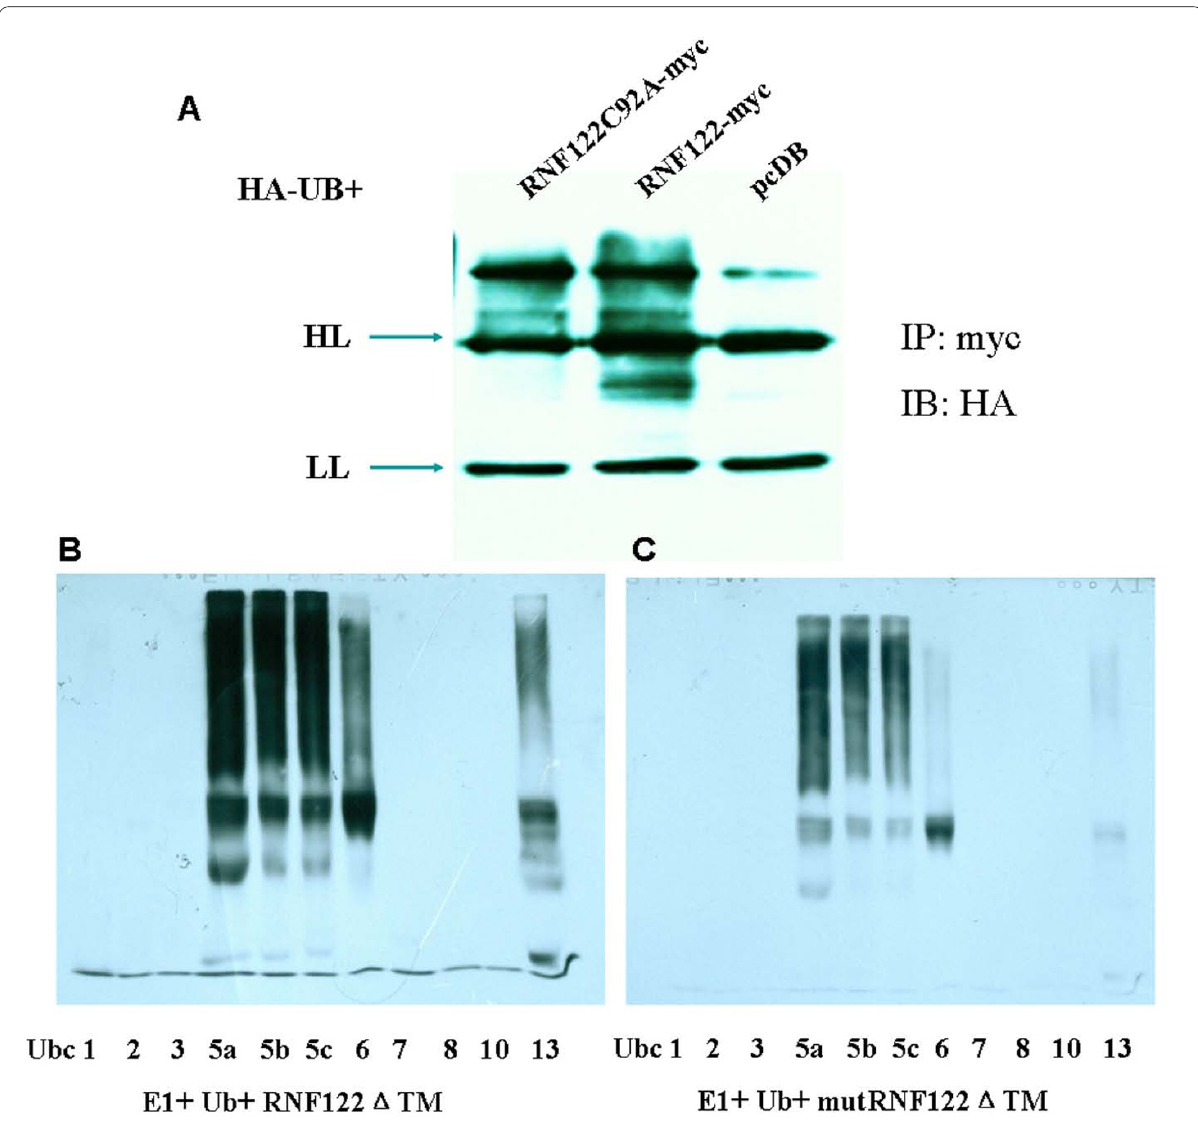
Figure 2 In vivo and in vitro ubiquitylation of RNF122 . (A) HEK293T cells were seeded into 60-mm plates and transfected with 5 μg of Ub-HA and 5 μg of pcDB (empty) or wild-type or mutant RNF122-myc expression plasmid. At 48 h post-transfection, cell lysates in RIPA buffer were immunopre- cipitated with anti-myc antibody agarose beads. The immunoprecipitates were analyzed on an immunoblot for HA. A smeared band was observed in the RNF122-myc group. (B) E2-selective ubiquitin ligase activity of RNF122. Bacterially expressed GST-RNF122ΔTM was incubated with ubiquitin, E1, and various E2 enzymes. Autoubiquitylation of RNF122 was detected by HRP-streptavidin immunoblotting. (C) RNF122 E3 ligase activity required an intact RING finger domain. The reactions were performed using ubiquitin, E1, E2 (UbcH5b or UbcH5c), and E3 (GST-RNF122ΔTM, or mutant GST- RNF122ΔTM), as